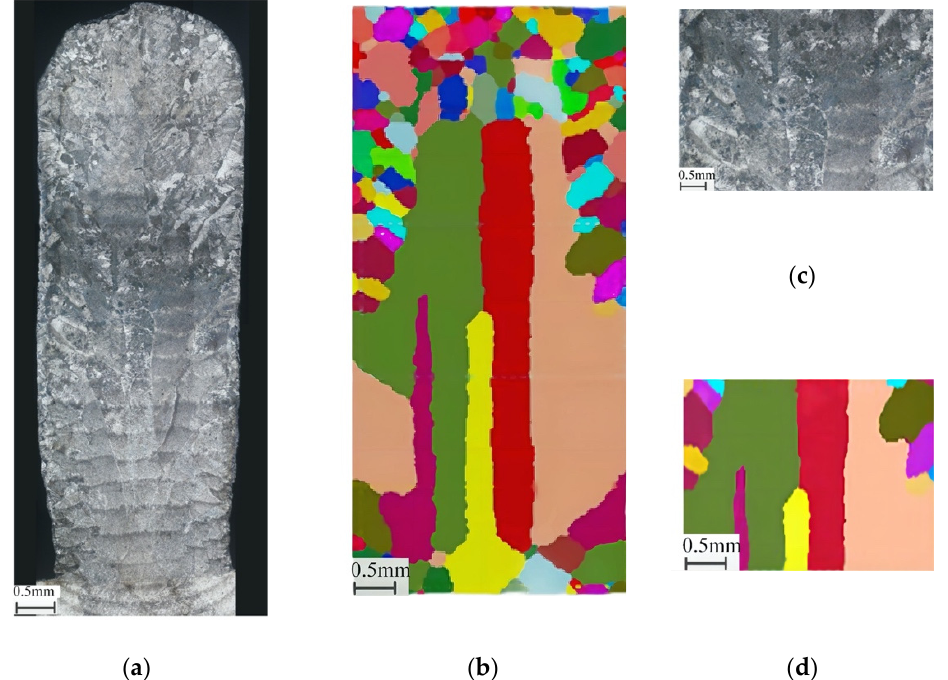
Figure 3. Solidification simulated by Monte Carlo model [33]. (Reprinted/adapted with permission from Ref. [33]. 2022, Springer nature). ( a ) experiment, ( b ) MC, ( c ) magnified figure of experiment, ( d ) magnified figure of MC